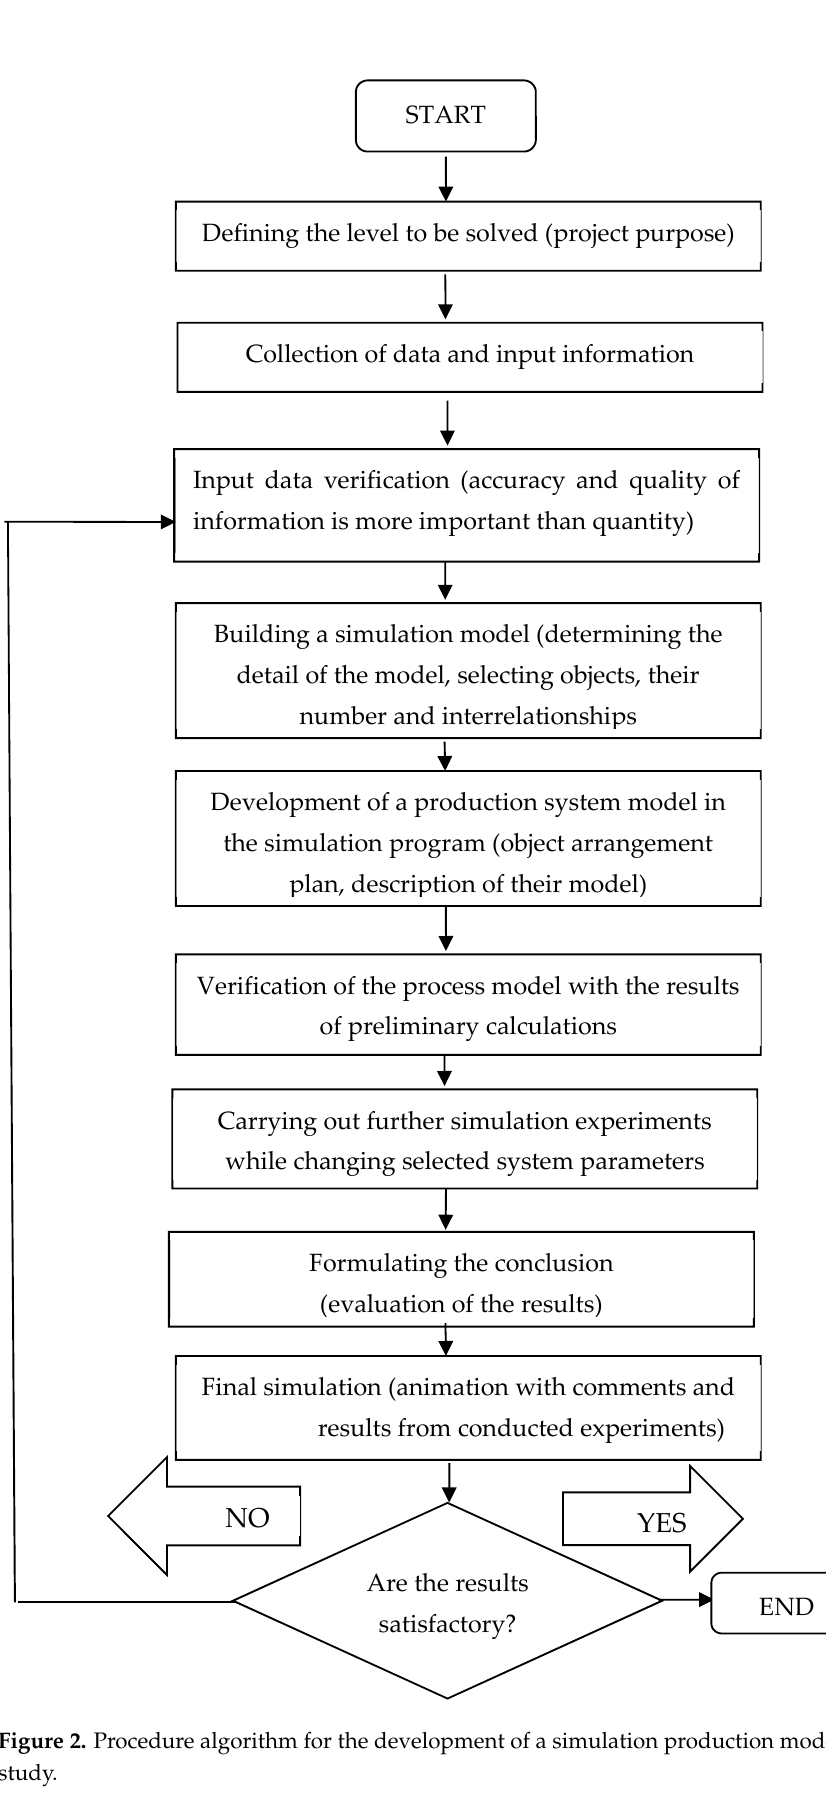
Figure 2. Procedure algorithm for the development of a simulation production model. Source: own